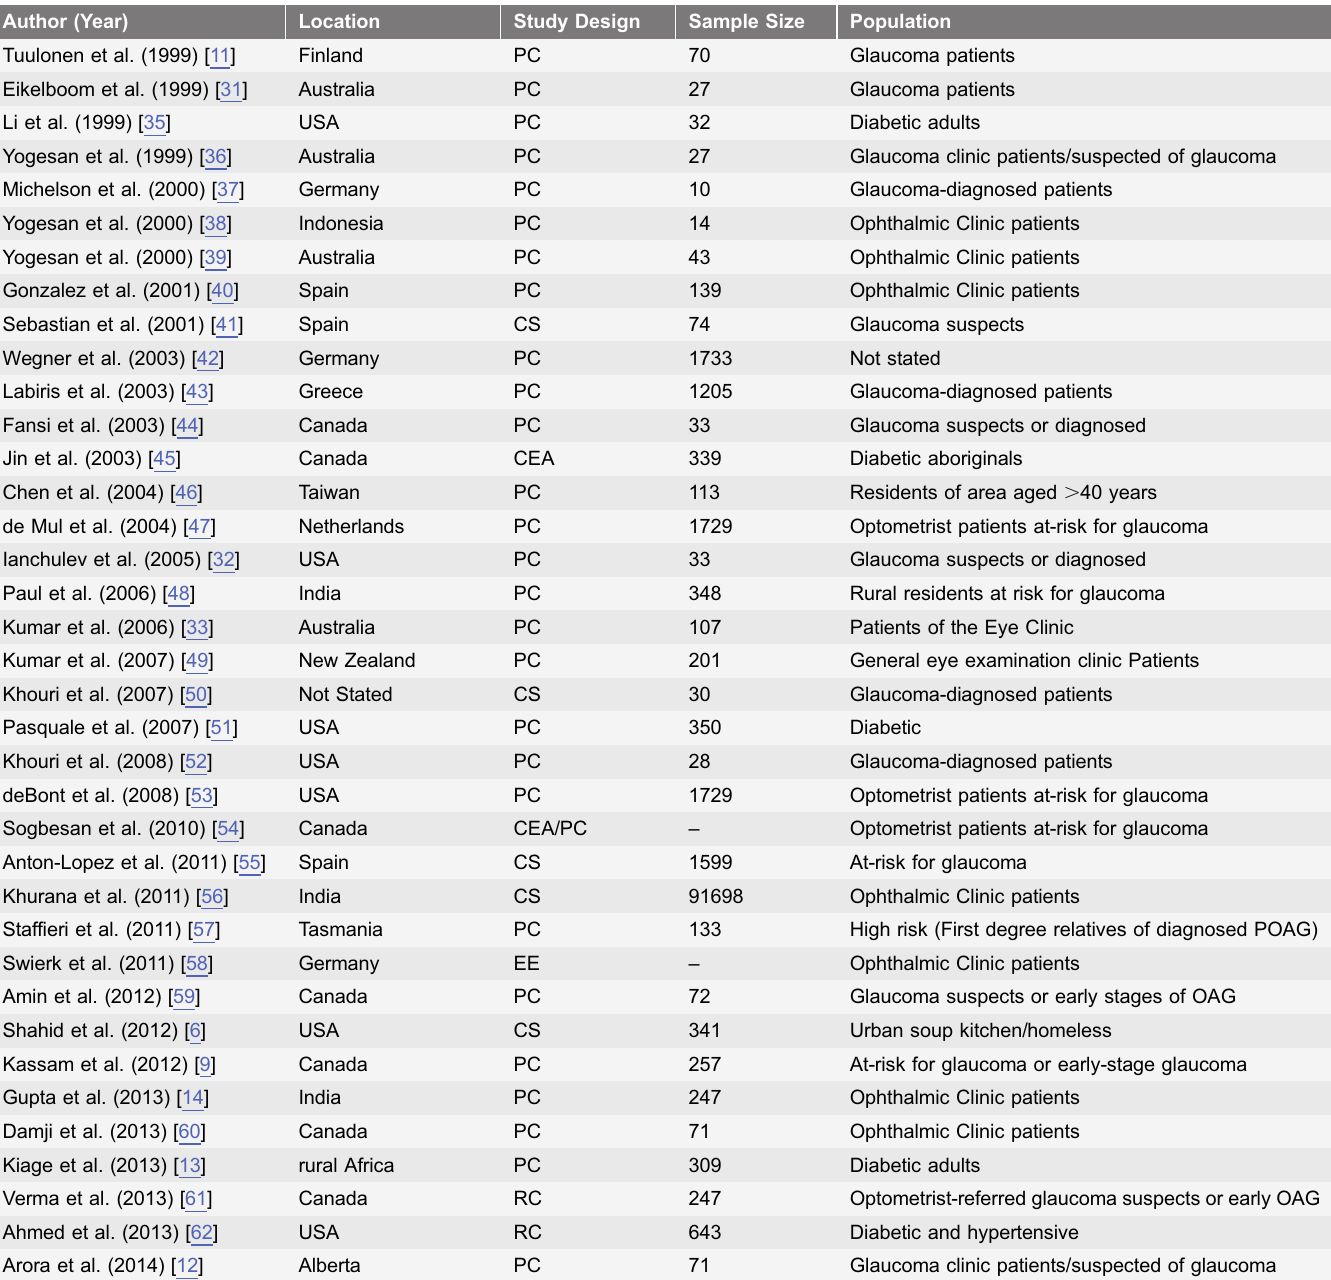
Table 2. Baseline characteristics of included studies –